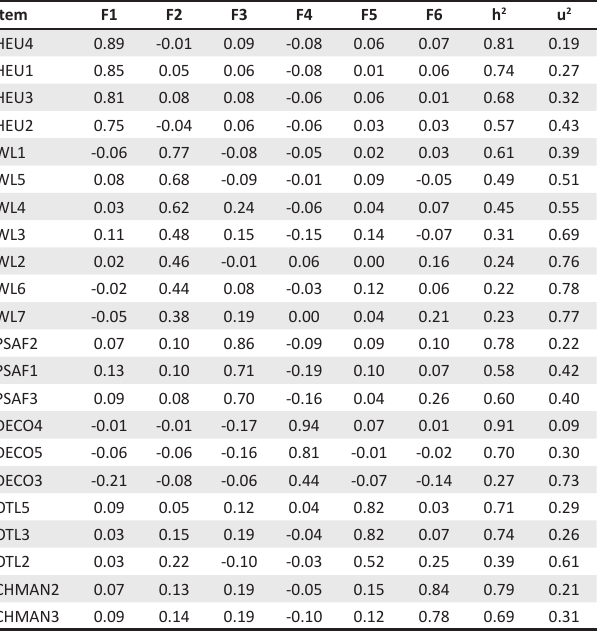
TABLE 3: Factor loadings for the final six-factor model of 22 items.